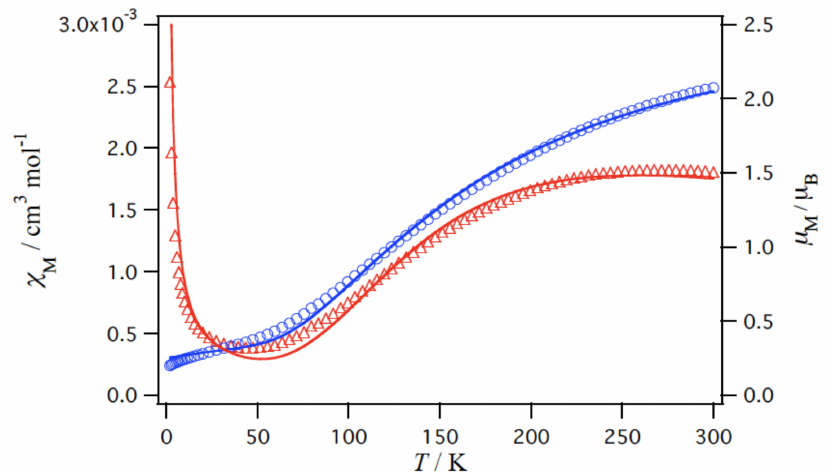
Figure 4. Temperature dependence of magnetic susceptibility χ M ( ∆ ) and magnetic moment µ eff ( ◦ ) of [Cu 2 (L 3 ) 2 ] ( 3